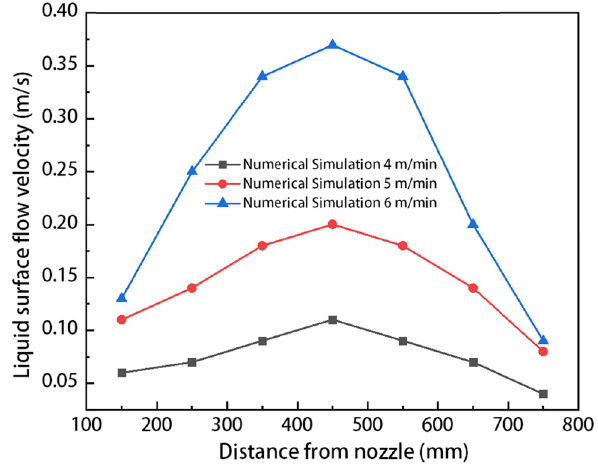
Figure 11: In fl uence of the casting speed on funnel mold surface